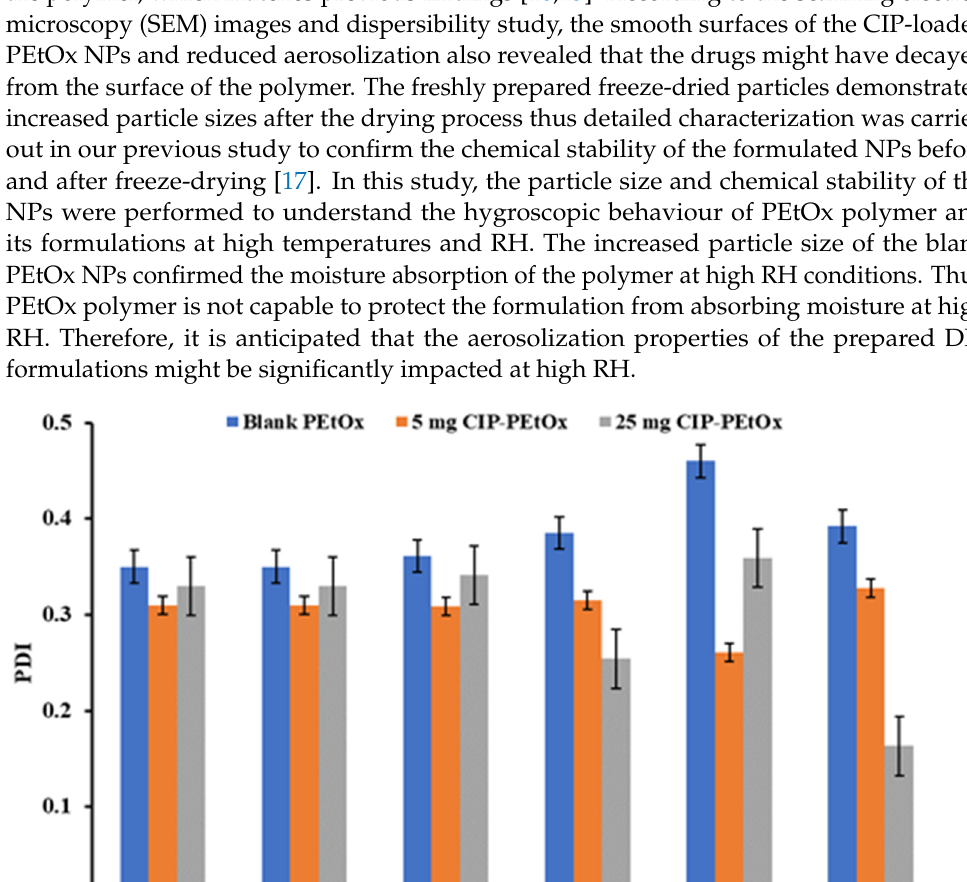
hand, 25 mg CIP-loaded PEtOx NPs revealed significantly ( p < 0.05) lower particle size after a 6-month storage period at 40 °C/75% RH conditions. However, these particles maintained close particle sizes to the initial sizes of 200 nm ( p > 0.05) at 25 °C/43% RH condition. No significant differences were observed among the particle size distributions of 5 mg and 25 mg CIP-loaded PEtOx NPs in any of the conditions (Figure 2). The findings revealed that blank PEtOx NPs maintained the particle size close to its initial particle size at room temperature (25 °C) and relative humidity (43% RH). However, CIP-loaded PE- tOx NPs showed reduced particle sizes from 200.2 nm to 126.3 nm after 6 months at high temperatures (40 °C) and RH (75% RH). CIP-loaded PEtOx NPs showed decreased parti- cle sizes because of polymer fusion at high temperatures and drug decay from the surface of the polymer, which matches previous findings [10,13]. According to the scanning elec- tron microscopy (SEM) images and dispersibility study, the smooth surfaces of the CIP- loaded PEtOx NPs and reduced aerosolization also revealed that the drugs might have decayed from the surface of the polymer. The freshly prepared freeze-dried particles demonstrated increased particle sizes after the drying process thus detailed characteriza- tion was carried out in our previous study to confirm the chemical stability of the formu- lated NPs before and after freeze-drying [17]. In this study, the particle size and chemical stability of the NPs were performed to understand the hygroscopic behaviour of PEtOx polymer and its formulations at high temperatures and RH. The increased particle size of the blank PEtOx NPs confirmed the moisture absorption of the polymer at high RH